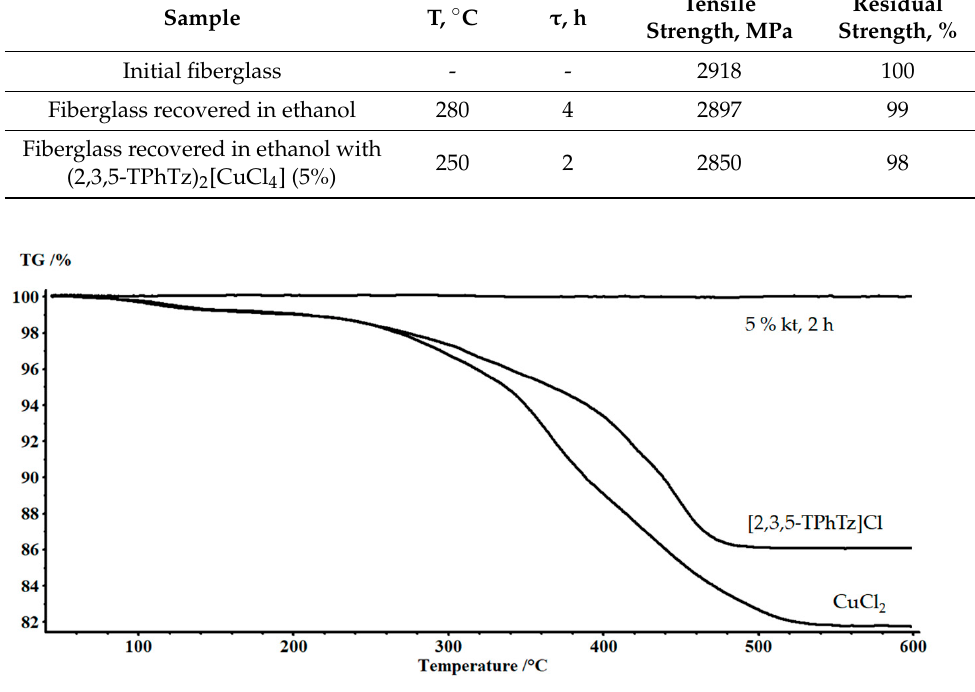
Figure 8. TG curves of recovered fi bers obtained using various catalysts.